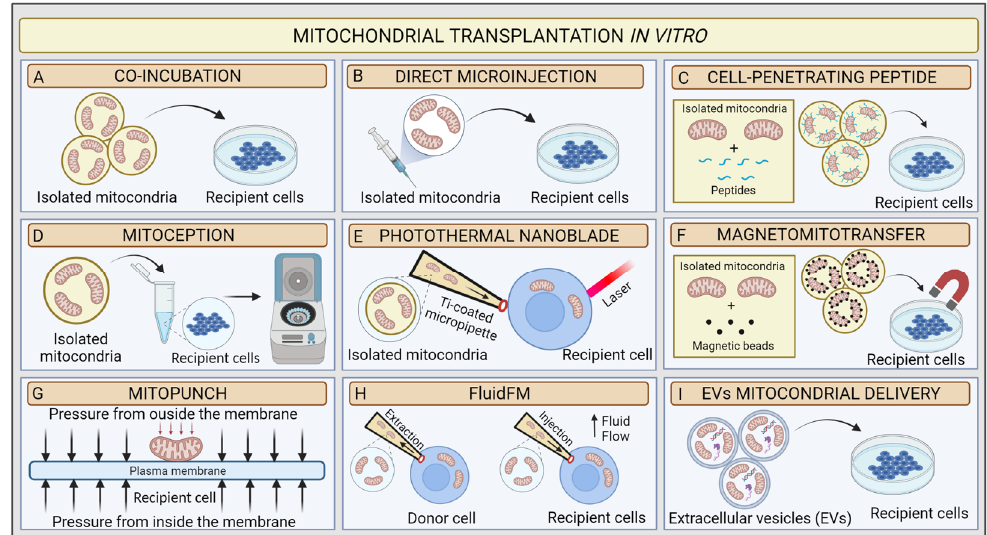
Figure 3. Schematic illustration of mitochondrial transplantation methods in vitro. ( A ) Coincuba- tion, ( B ) direct microinjection, ( C ) cell-penetrating peptide mitochondrial delivery, ( D ) mitoception, ( E ) photothermal nanoblade, ( F ) magnetomitotransfer, ( G ) Mitopunch, ( H ) FluidFM, ( I ) EV mito- chondrial delivery.